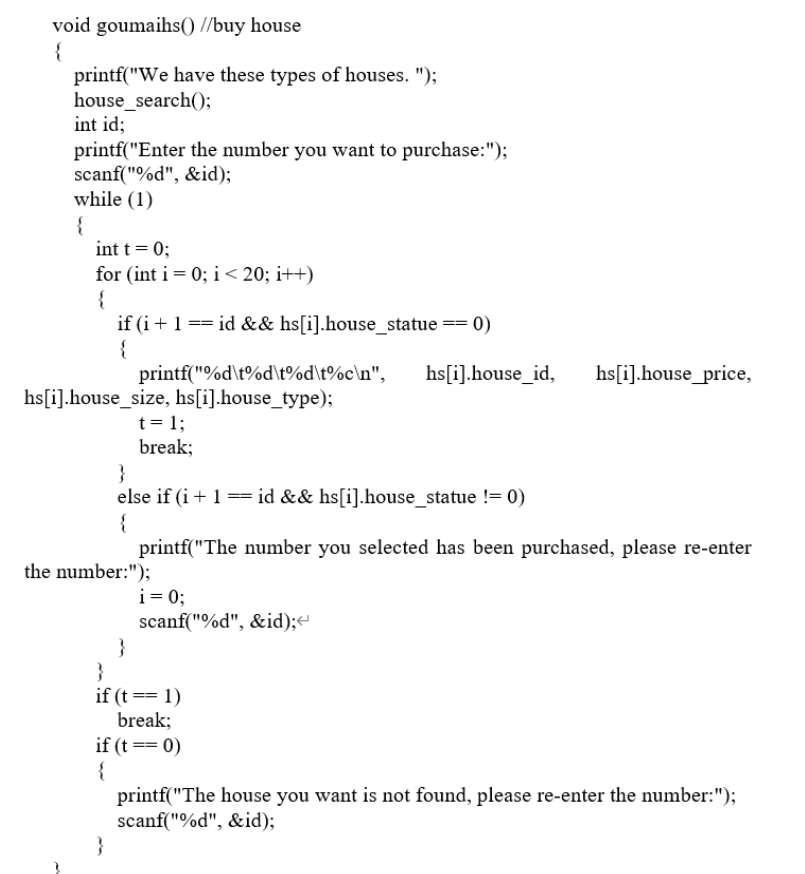
Fig. 3. Hs[i].house statue applied to the housing management